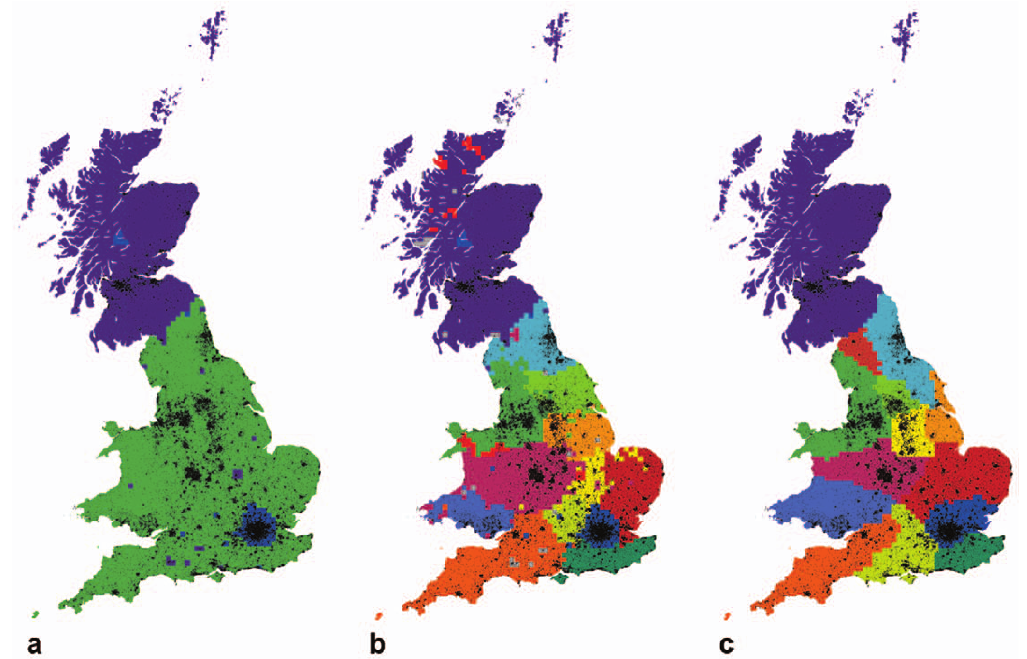
Figure 2. Defining regions through the spectral modularity optimization of telecommunications networks. a - even with just three regions we obtain a total modularity of 0.31, indicating a fairly good network partitioning. b - the final partitioning of Great Britain yields a modularity of 0.58. c - further fine tuning according to the process suggested by Newman [16] increases the modularity to 0.60.